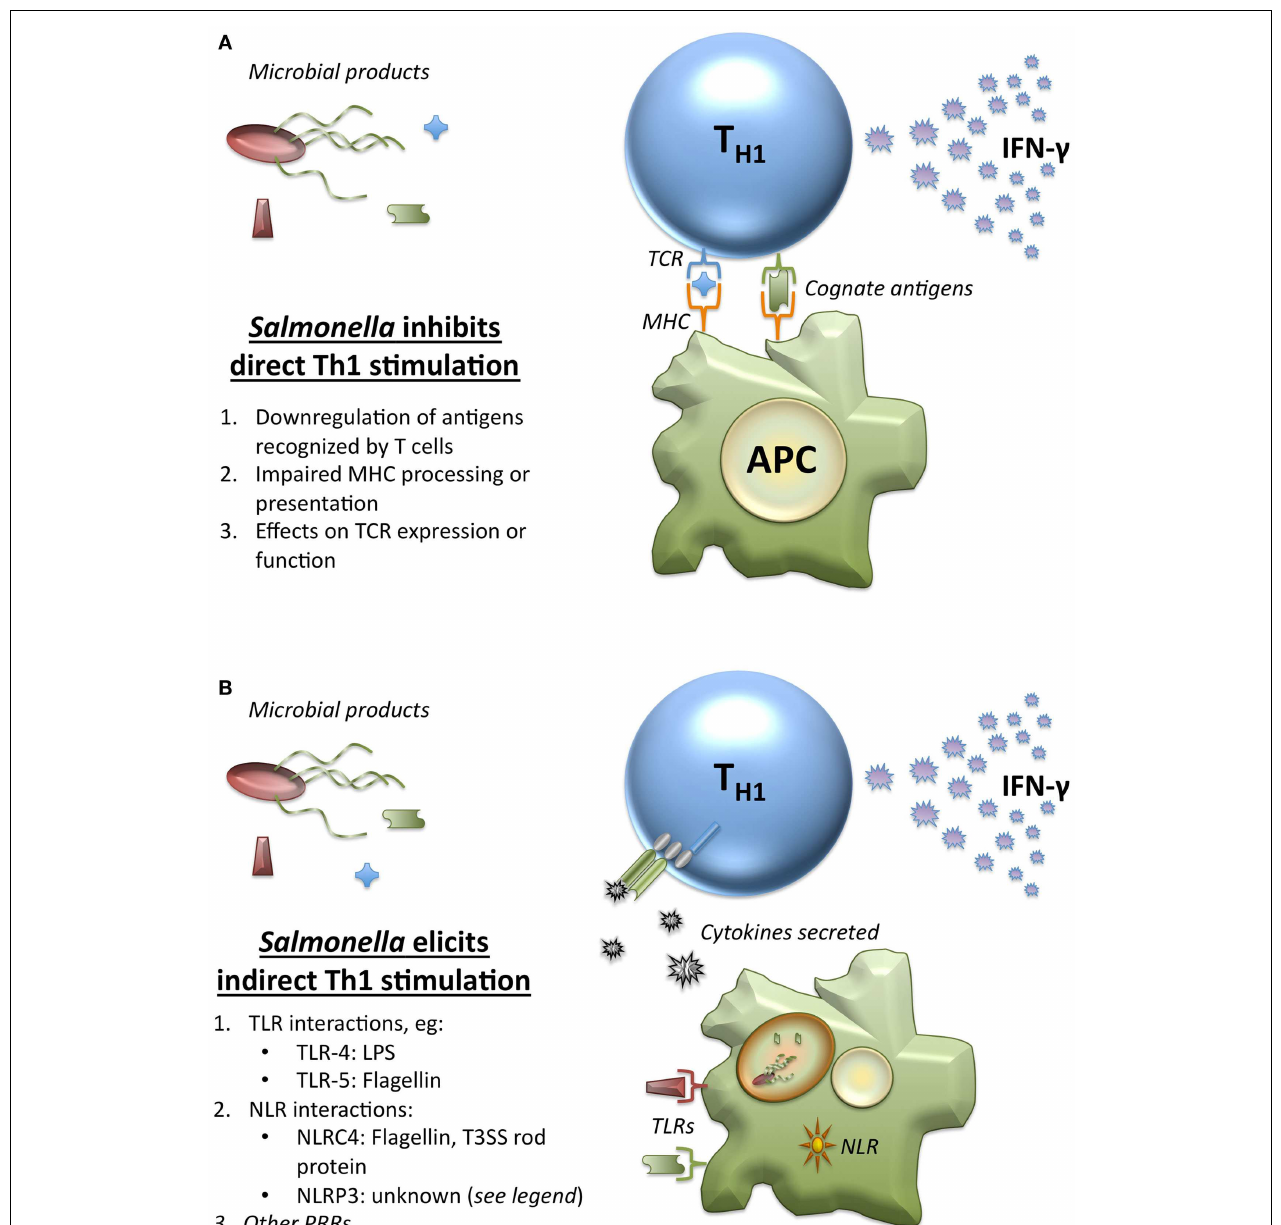
Salmonella , and these elicit cytokines that allowTh1 cells to be stimulated by non-cognate pathogen products indirectly at sites of infection. (1) Several TLRs recognize conserved patterns present in Salmonella , includingTLR-4 recognition of LPS,TLR-5 recognition of flagellin, and otherTLRs that recognize bacterial nucleic acids from within the endolysosome. (2)The role of NLRs and the inflammasomes have also been well-demonstrated for cytosolic nucleic acid sensing